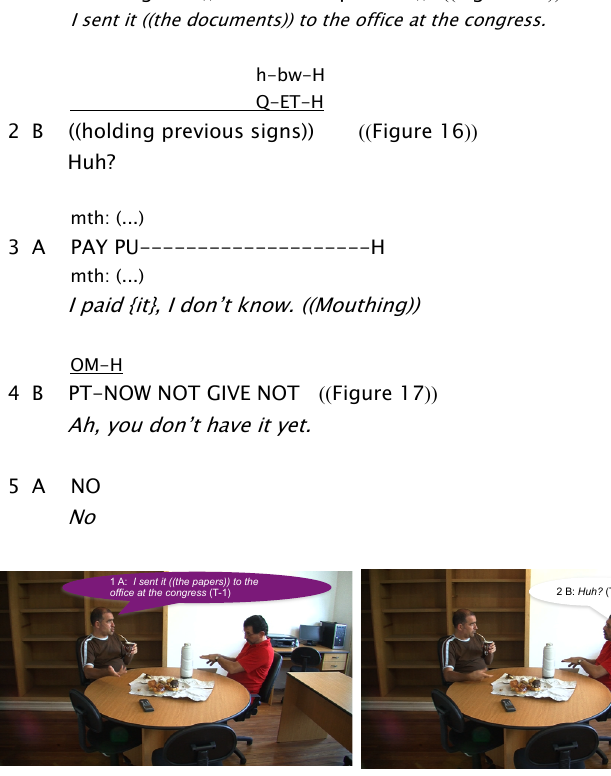
Figure 15. ‘I sent it ((the documents)) Figure 16. ‘Huh?’ , Person B, on the